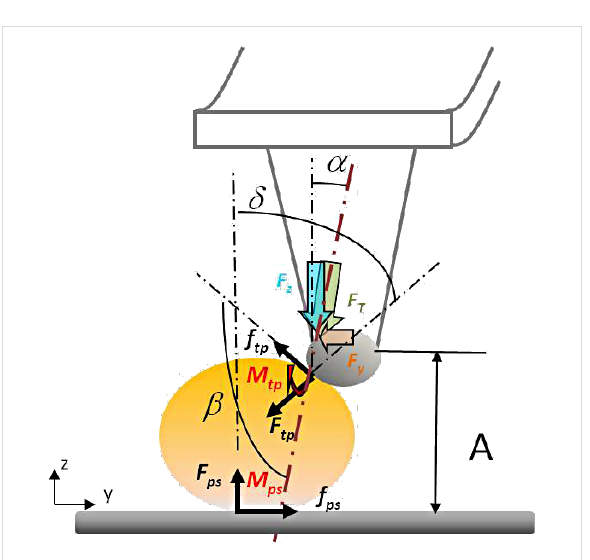
Scheme 1: Scheme presenting the different forces during tip–particle and particle–substrate interactions, and the angles α , β and δ